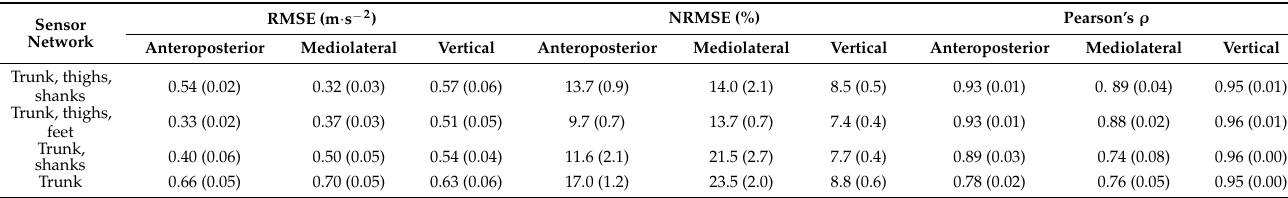
Table 3. Accuracy of sensor-network-based MIMU-derived BCoM acceleration as compared with force-platform-based acceleration in terms of root mean square error (RMSE), normalized RMSE and Pearson’s correlation coefficient ( ρ ). Means (standard deviations) over the considered stride cycles are